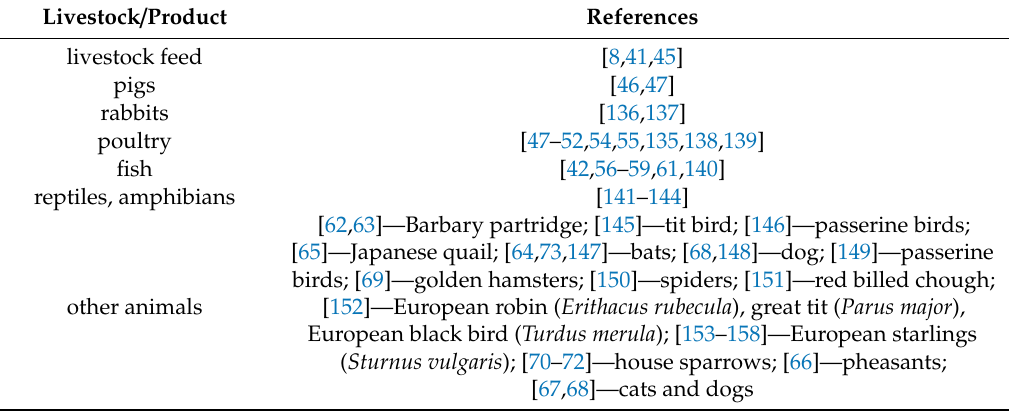
Table 5. Research into the use of mealworms as